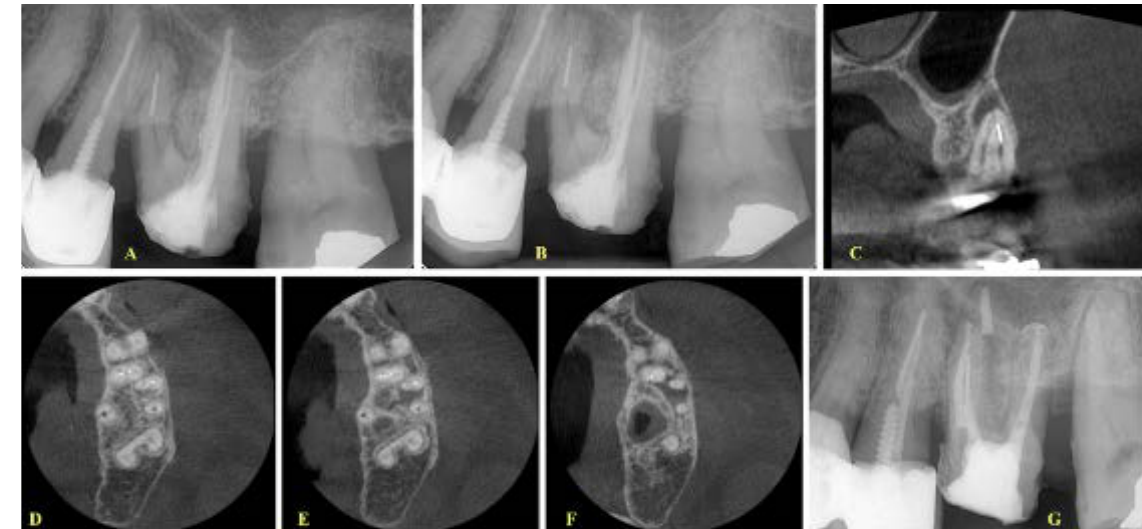
Figure 3. ( A ) Initial periapical radiograph of a mandibular first molar with periapical lesions and a fragment at the apical third of the mesial root (mesiobuccal canal), ( B , C ) . Coronal and axial views demonstrating that the two canals are merging at the apical third ( D ) Final radiograph with the fragment in place. No attempt was made to remove the fragment. Apical patency was achieved through the mesiolingual canal.